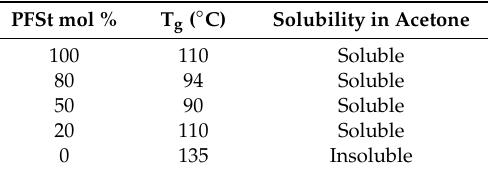
Table 7. Physical data of PFMMD and PFSt.